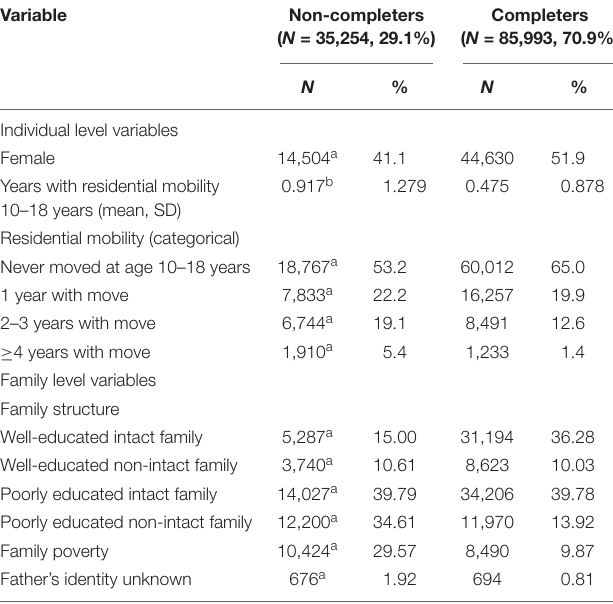
TABLE 1 | Characteristics of children and their parents by whether or not the children completed upper secondary education by age 21.